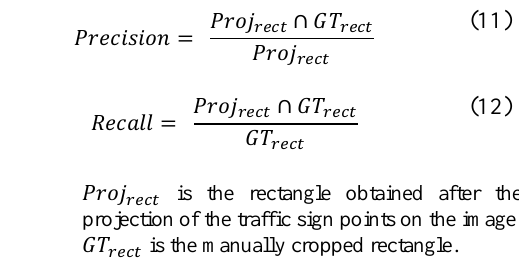
Table 2. Assessment and comparison of the method.